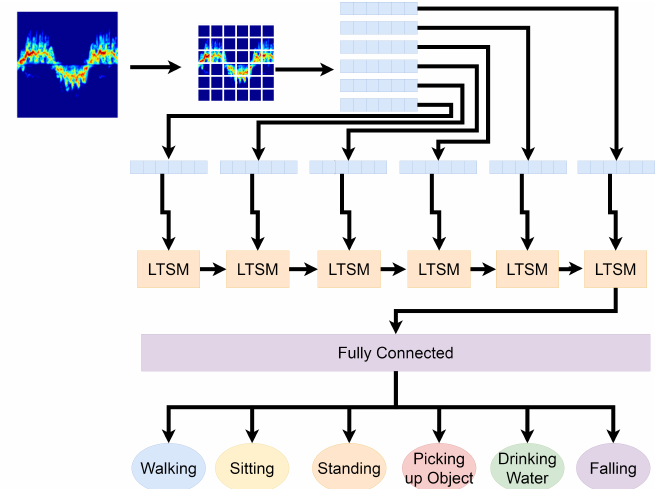
Figure 3. Visual representation of how LSTM